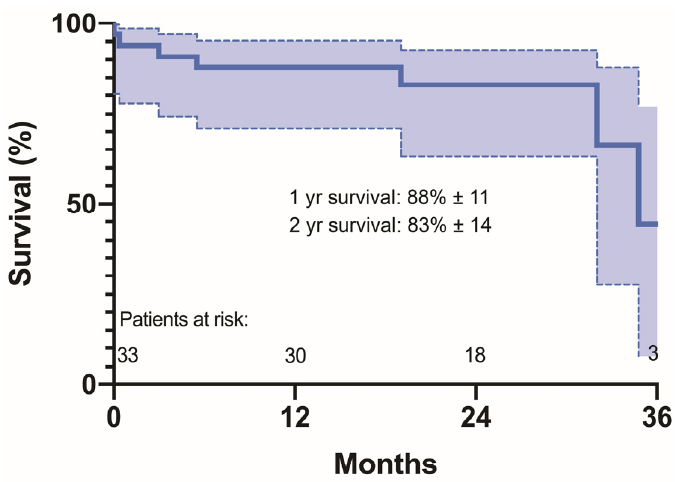
Figure 3. Kaplan–Meier survival curves.